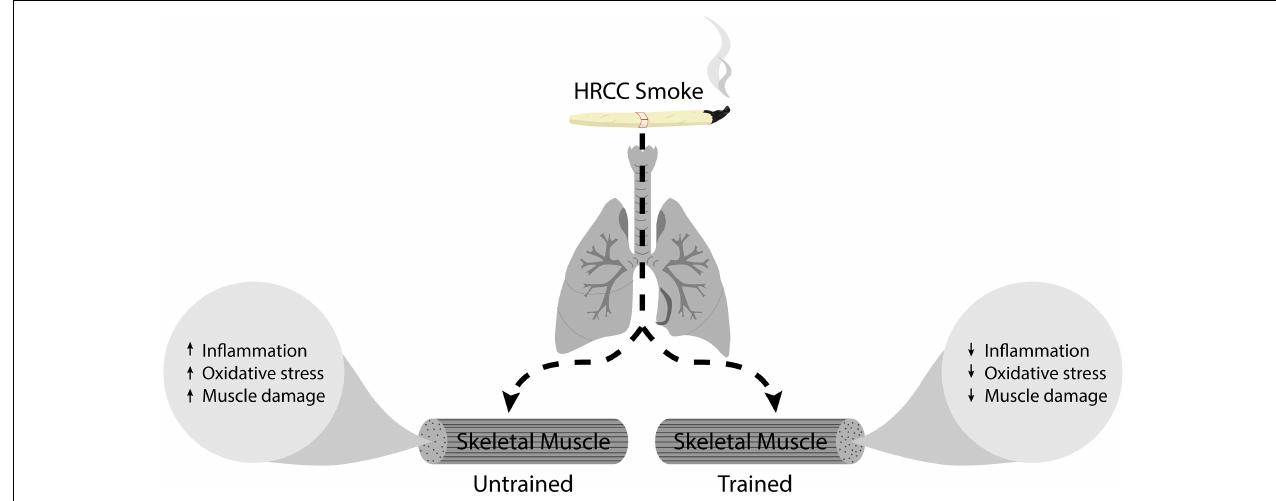
FIGURE 6 | Represents the schematic diagram of HRCC smoke effect on trained and untrained skeletal muscle.